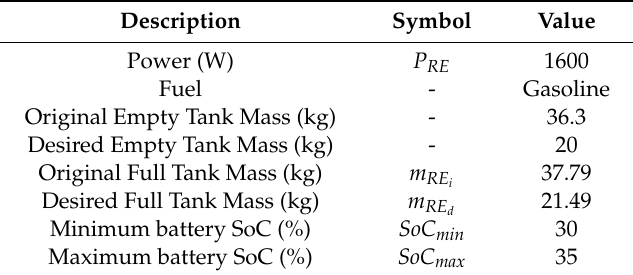
Table 2. RE specifications.